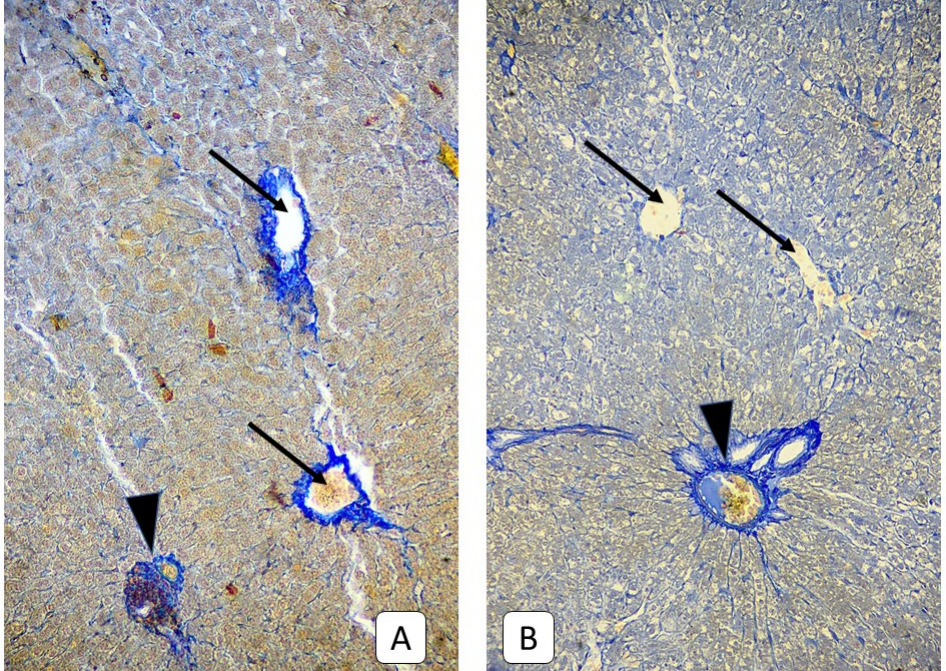
Figure 9. Photomicrograph of the liver. ( A ): adult rats, 21st day after mTBI. Collagen near central veins (arrow) and portal triads (arrowhead). ( B ): control group. Central veins (arrow) and collagen near portal triads (arrowhead) Mallory’s trichrome, ×400.